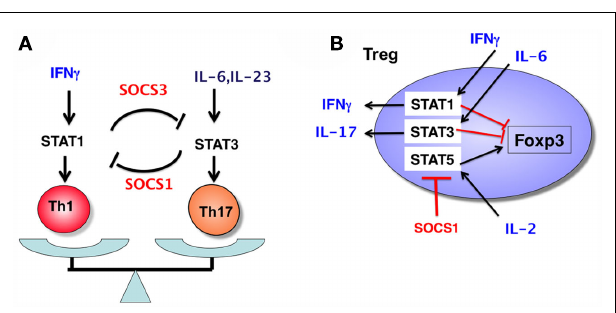
FIGURE 4 | Role of SOCS1 and SOCS3 inTh1/Th17 balance (A) and in nT reg integrity (B). InTh1 conditions, activated STAT1 induces SOCS3 expression, which in turn inhibits STAT3 activity, thereby suppressingTh17 development. InTh17 conditions, SOCS1 is highly expressed and inhibits IFN γ -mediatedTh1 development. In nT regs , the SOCS1 level is constantly high, and suppresses STAT1, STAT3, and STAT5 in inflammatory conditions (high levels of cytokines such as IL-2, IL-6, and IFN γ ).The higher activation of STAT5 results in an increase in the number ofT regs , because STAT5 directly upregulates Foxp3 expression.The higher activation of STAT1 and